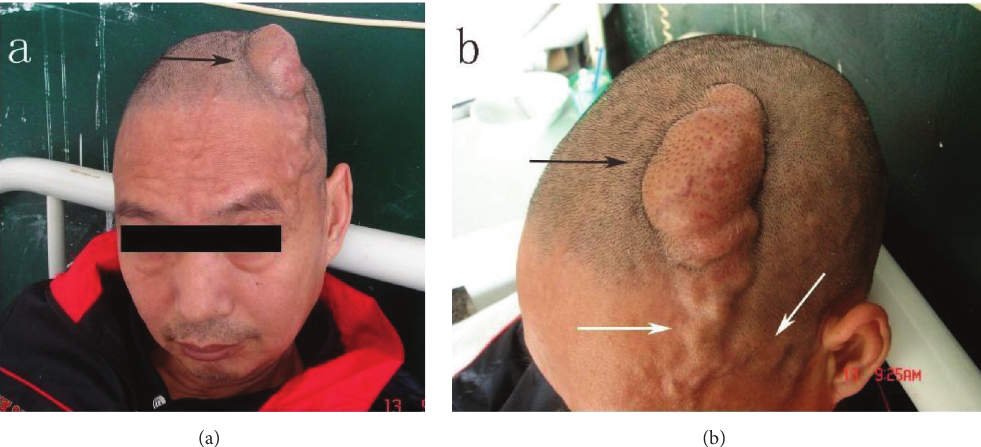
Figure 1: Macroscopic picture of the patient’s head. (a) The black arrow points to a large mass in the left temporoparietal area. (b) The white arrow is pointing to the left tortuous STA; the black arrow shows the vascular mass, which was pulsatile, and presented a clear wind-like murmur on auscultation. STA: superficial temporal artery.